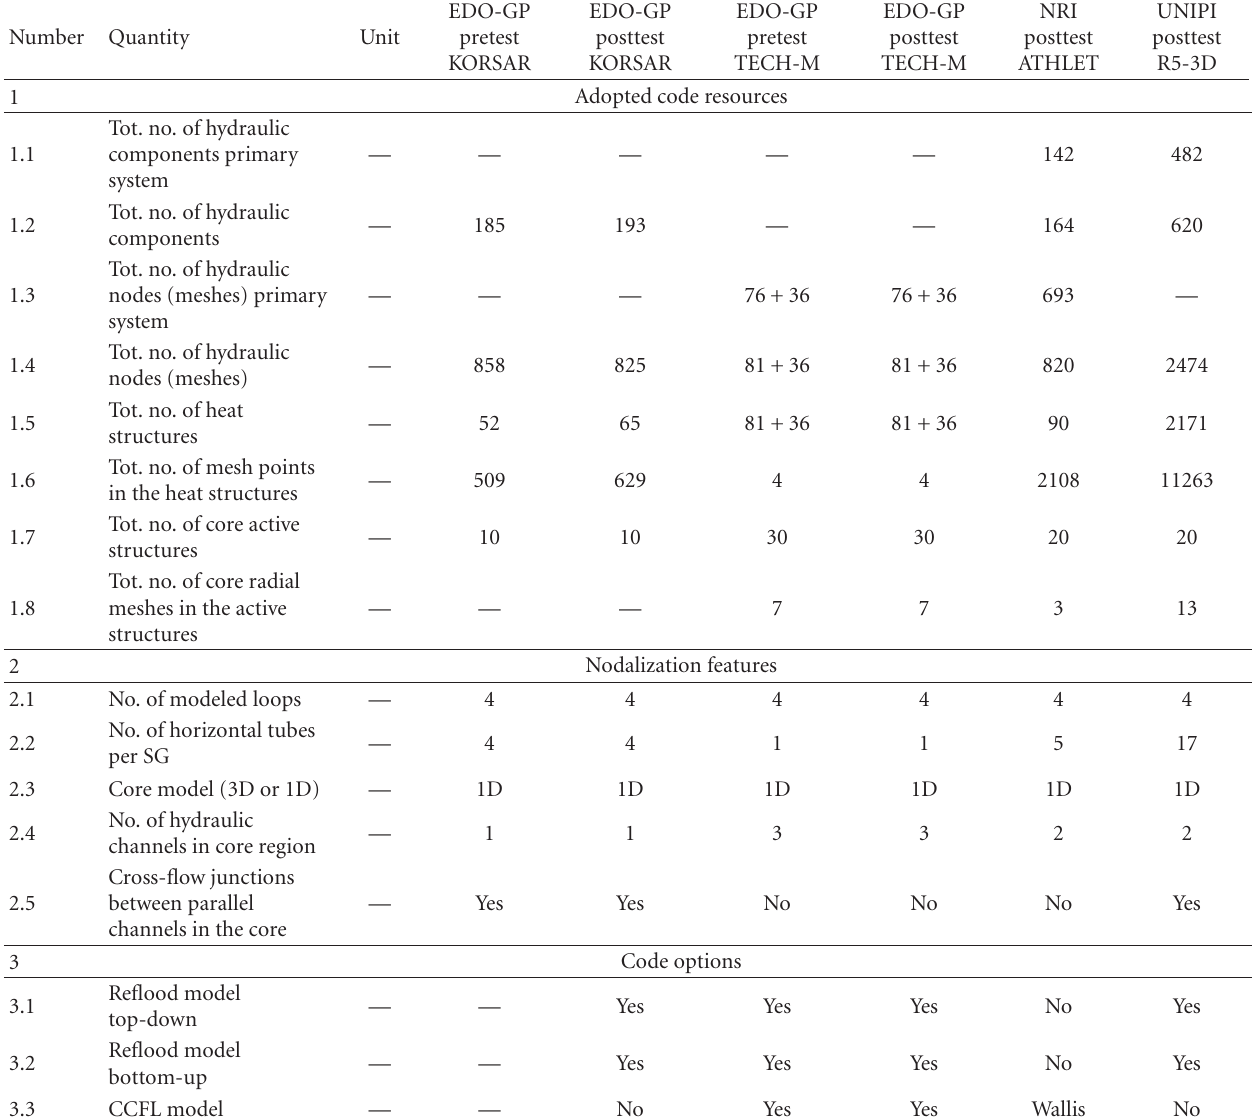
Table 2: Information on nodalizations and the code